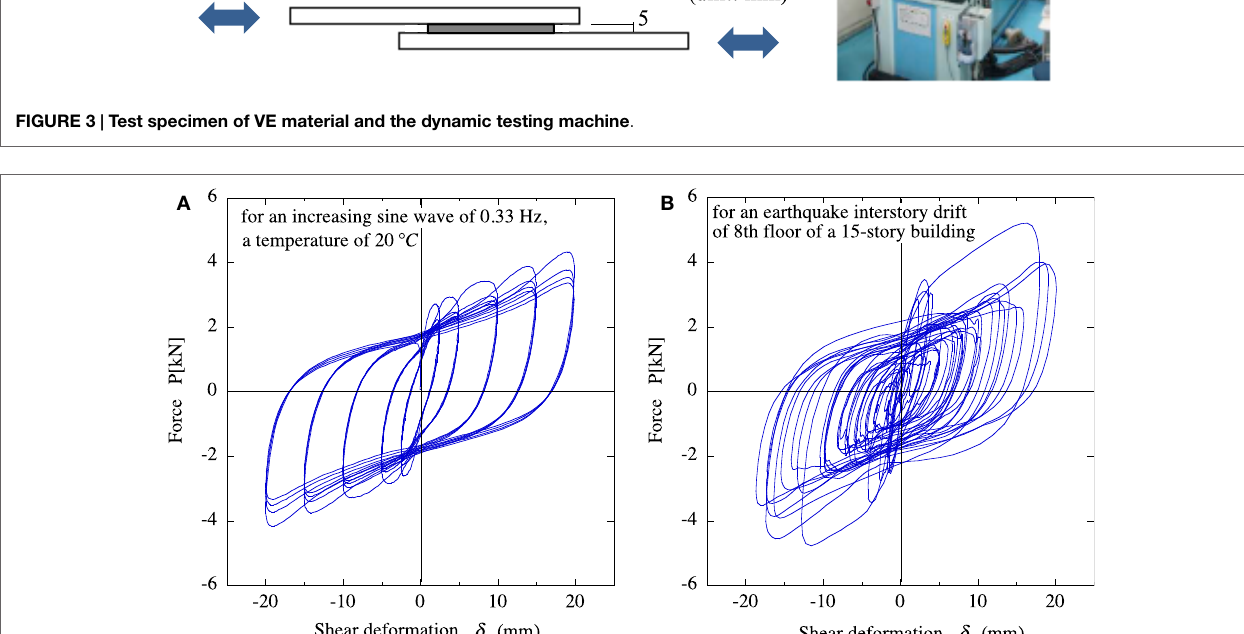
FIGURE 4 | Resisting force characteristics of VE material . (A) for an increasing sine wave and (B) for an earthquake interstory